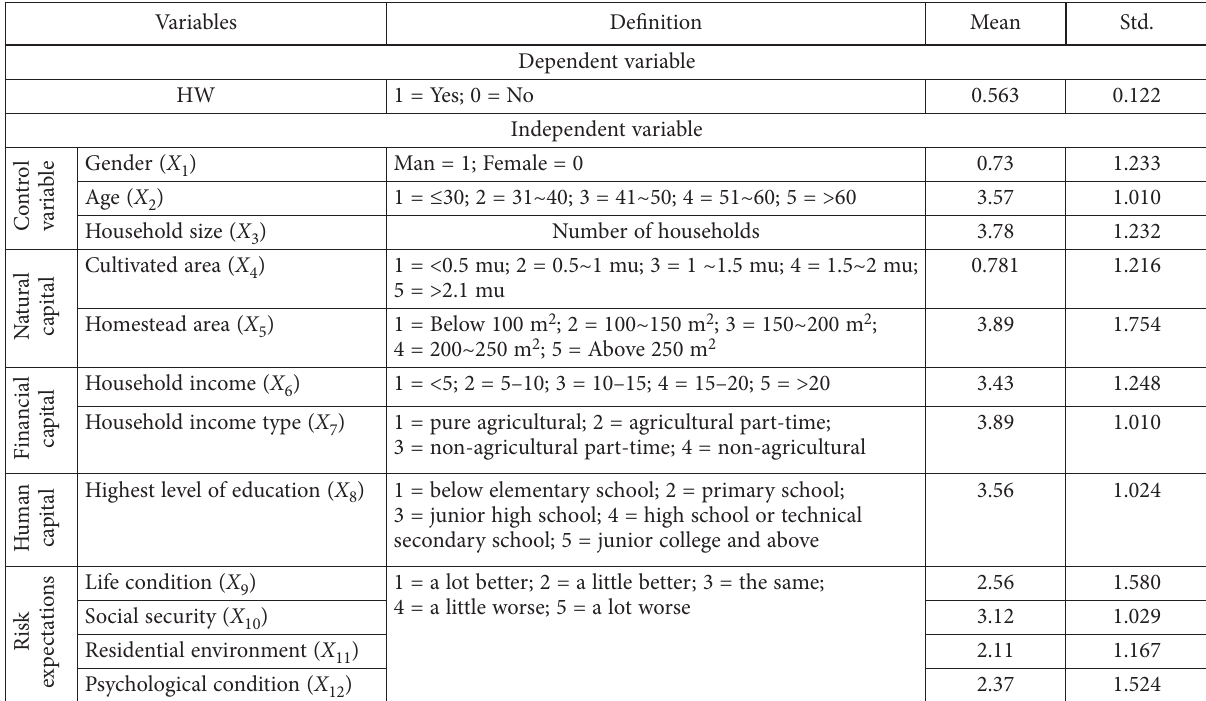
Table 1. Variable definition and descriptive